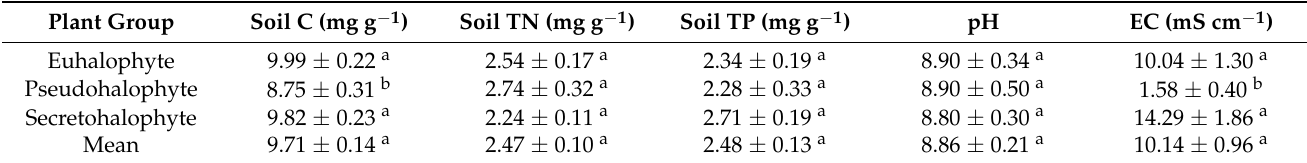
Table 2. Multiple comparisons of soil factors of different functional groups of saline shrubs.